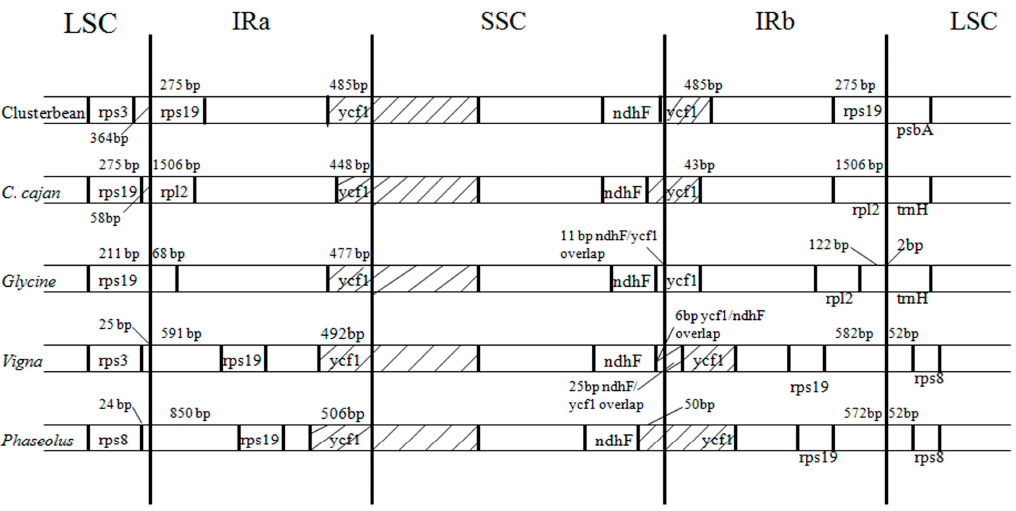
Figure 4. Comparison of the border positions of LSC, SSC and IR regions among the legume genomes. Genes are denoted by boxes, and the gaps between the genes and the boundaries are indicated by number of bases, unless the gene coincides with the boundary. Extensions of the genes are also indicated above the boxes.